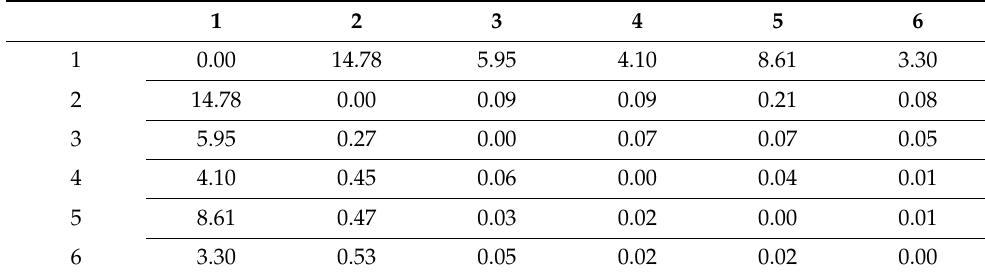
Table 6. Weighted distance sorting of distress